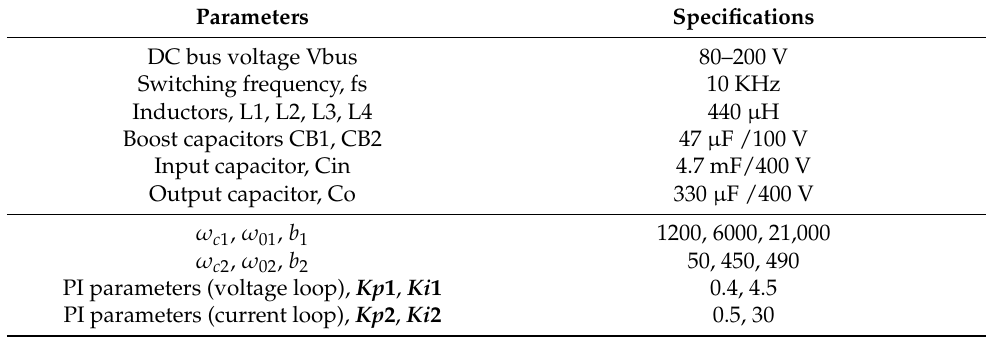
Table 1. Simulation